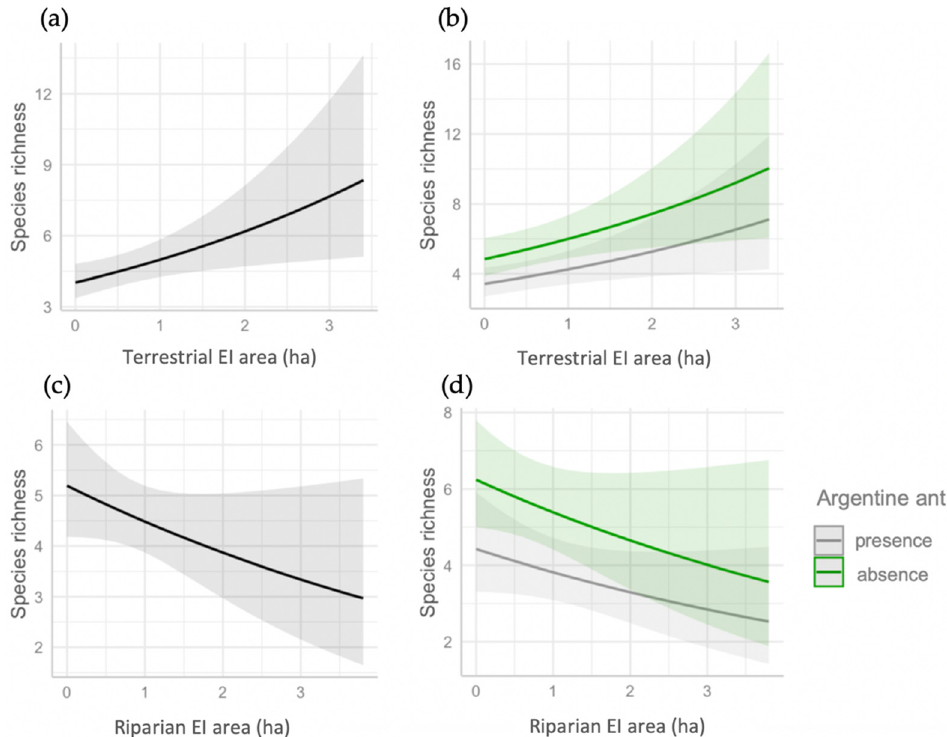
Figure 6. Predicted responses of the ant species richness in relation to the riparian and terrestrial ecological infrastructure (EI) proportional area in the 200 m buffer, overall ( a , c ) and considering the Argentine ant presence ( b , d ). Model predictions from GLMMs and associated 95% confidence intervals are represented by the solid lines and shaded areas,